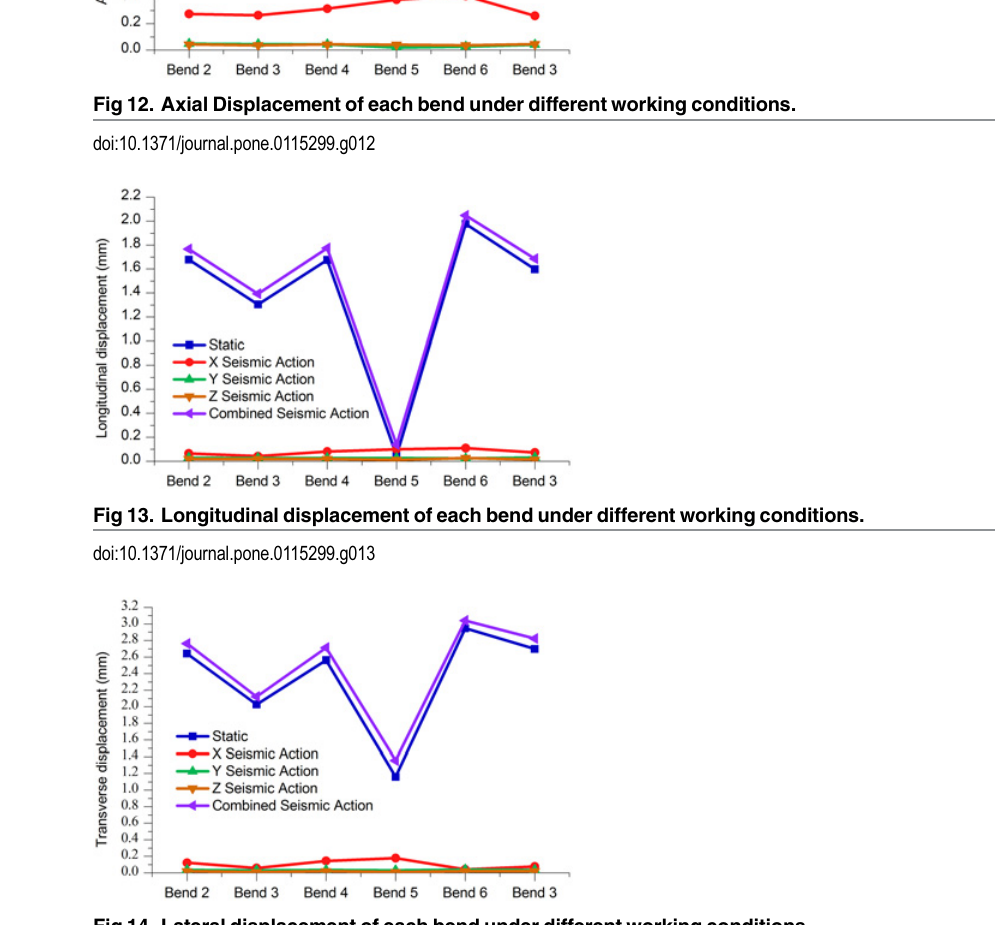
Fig 14. Lateral displacement of each bend under different working